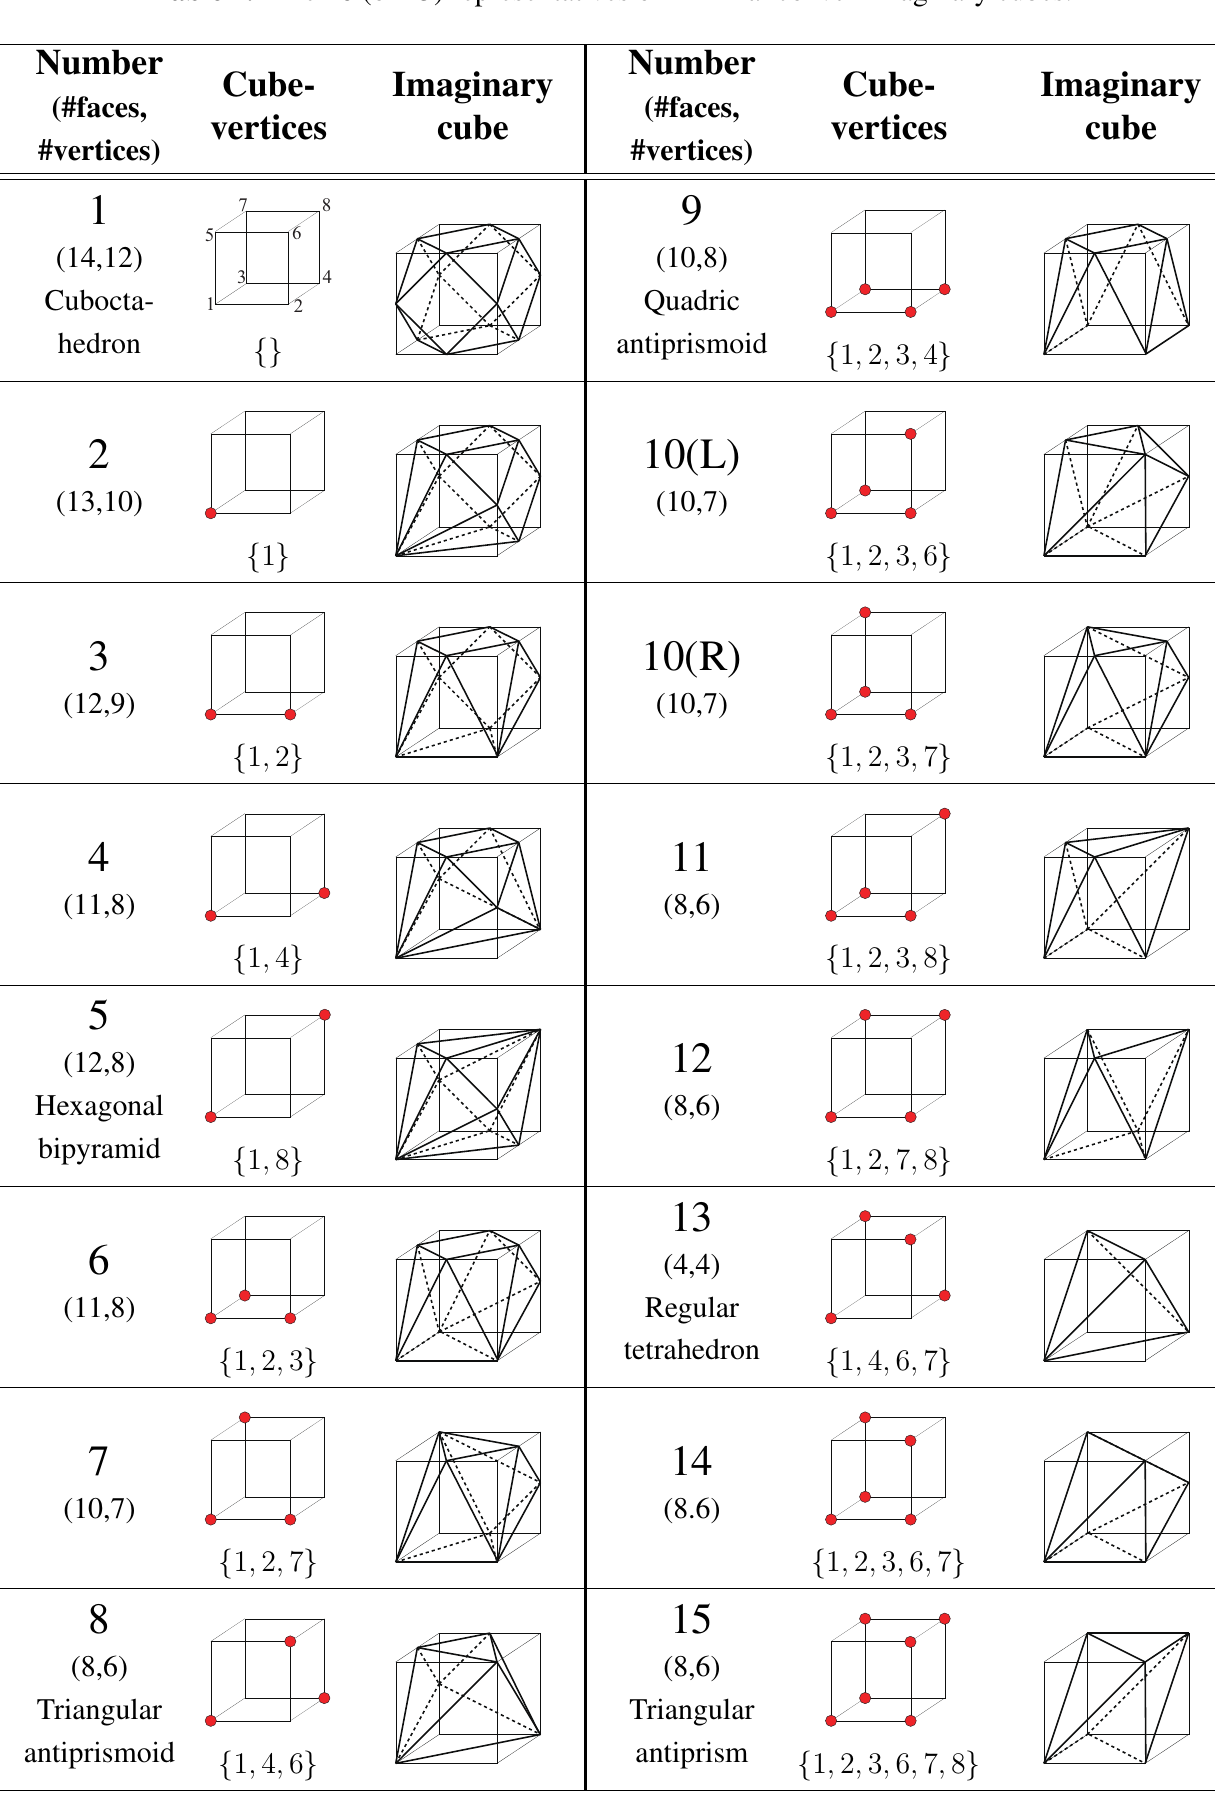
Table 1. The 16 (or 15) representatives of minimal convex imaginary